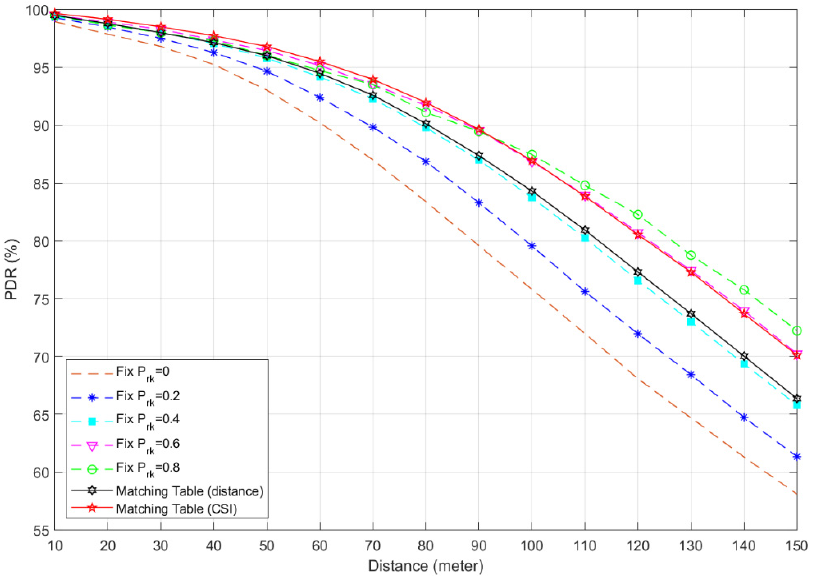
Figure 2. PDR performance comparison of matching table and fixed P rk value for n V = 400-vehicle scenario.